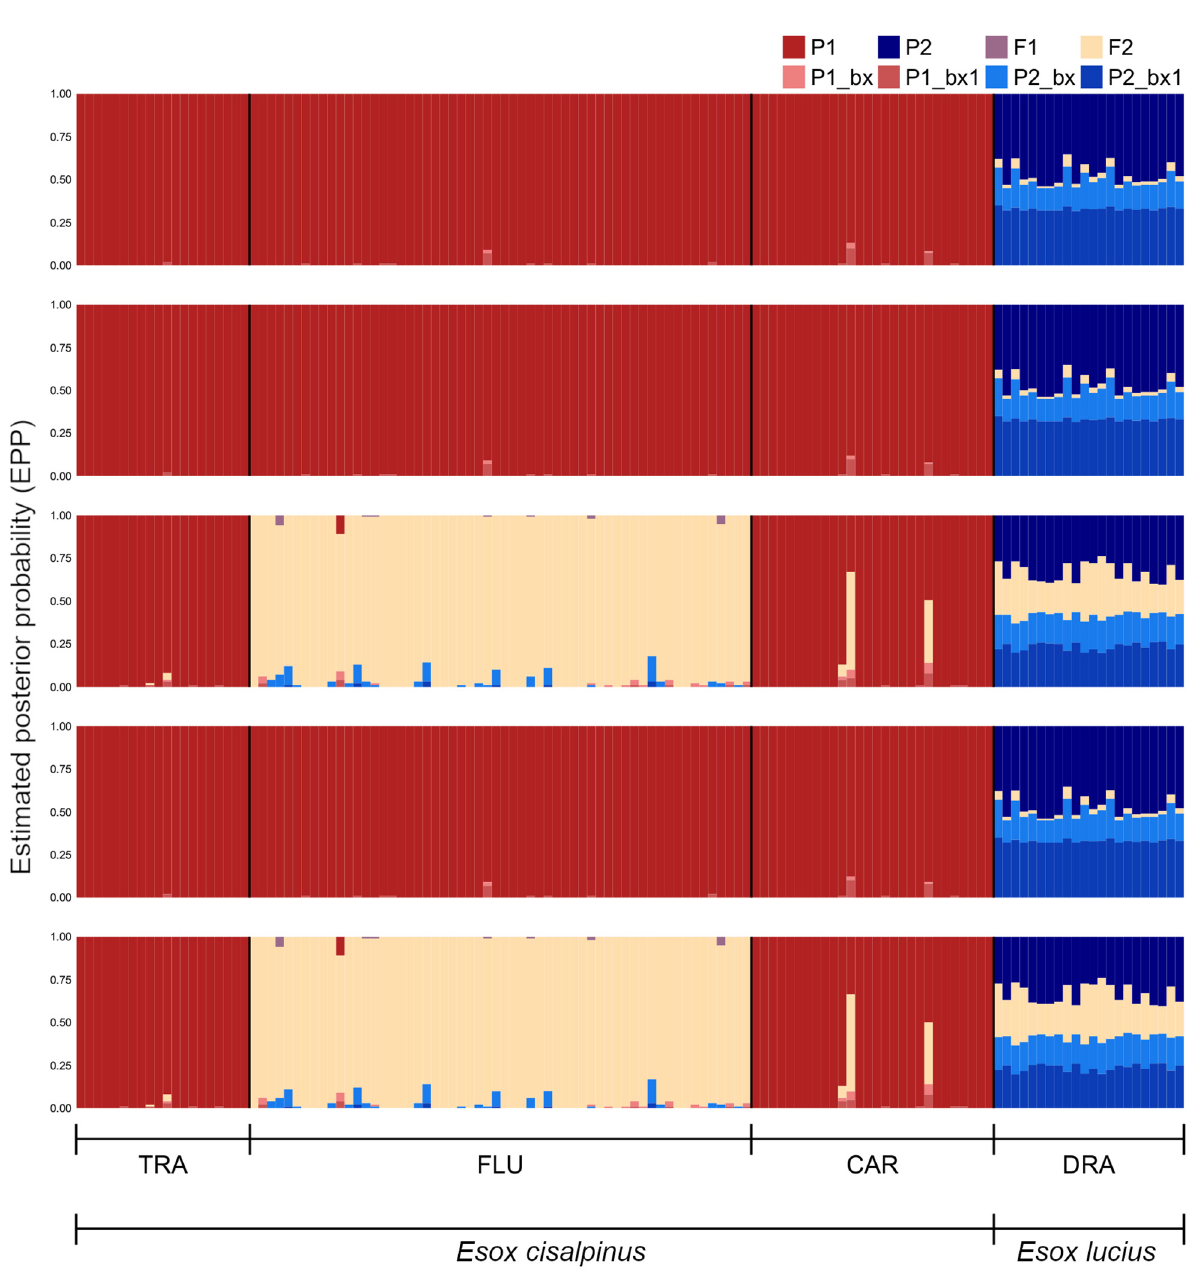
Figure 4. Bayesian model-based assignment of individuals to different genotypic classes. Each bar plot represents the output of an independent run of the algorithm, in which individuals are repre- sented by vertical bars subdivided into coloured segments. The height of each segment corresponds to the assignment probability of an individual to a given genotypic class. P1 and P2 represent pure parental classes. Other classes correspond to F1 and F2 hybrids, that is, first- and second-generation backcrosses between F1 with southern (P1_bx and P1_bx1, respectively) and northern pike (P2_bx and P2_bx1, respectively).